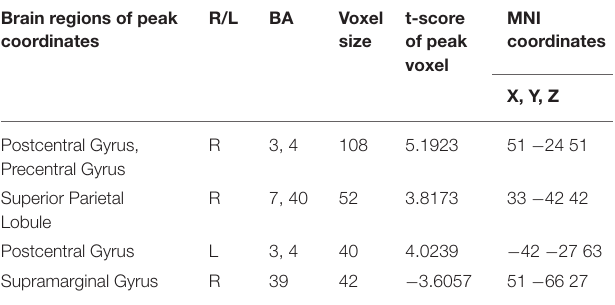
Between-group differences in binarized shortFCD thresholded at r = 0.3. The statistical threshold was set at corrected significance level of individual two-tailed voxel-wise p < 0.05 using an AlphaSim corrected threshold of cluster p < 0.05. longFCD,long-rangefunctionalconnectivitydensity;R,right;L,left;BA,Brodmann’sarea; MNI, Montreal Neurological Institute; N/A, Not applicable.